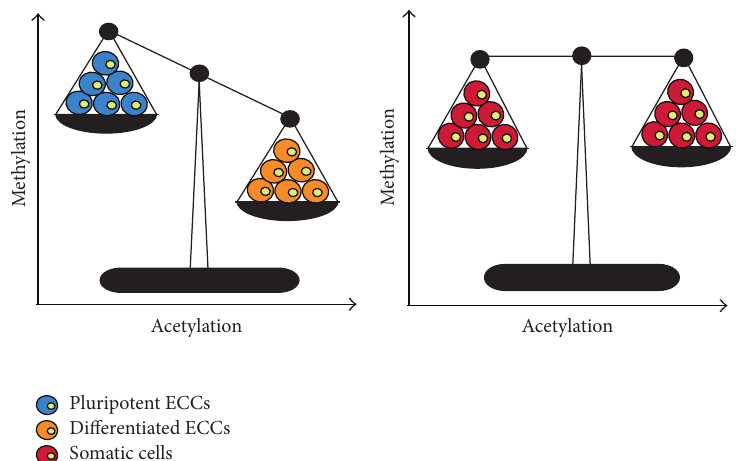
Figure 3: Global methylation and acetylation pattern of ECC lines during stemness and differentiation. Pluripotent ECCs are methylated and deacetylated yielding a low expression profile of differentiation markers. The dimerization of Jun Dimerization Protein 2 (JDP2) results in the recruitment of Histone Deacetylase 3 (HDAC3), which interacts and inhibits Histone Acetylases (HATs) from activating differentiation genes. Pluripotency is lost when DNA methyltransferase 1 (Dnmt1) expression and activity is reduced, resulting in the demethylation of differentiation-inducing genes including Vimentin , Laminin B1, Collagen IV, and Endo A . Similarly, HDAC activity is reduced as the p300 complex displaces the JDP2/HDAC3 complex, resulting in the recruitment of HATs and initiation of c-Jun transcription leading to